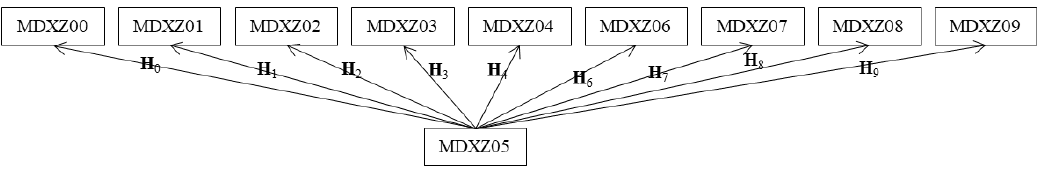
Figure 12. The relationship between video frames when using Strategy-S.